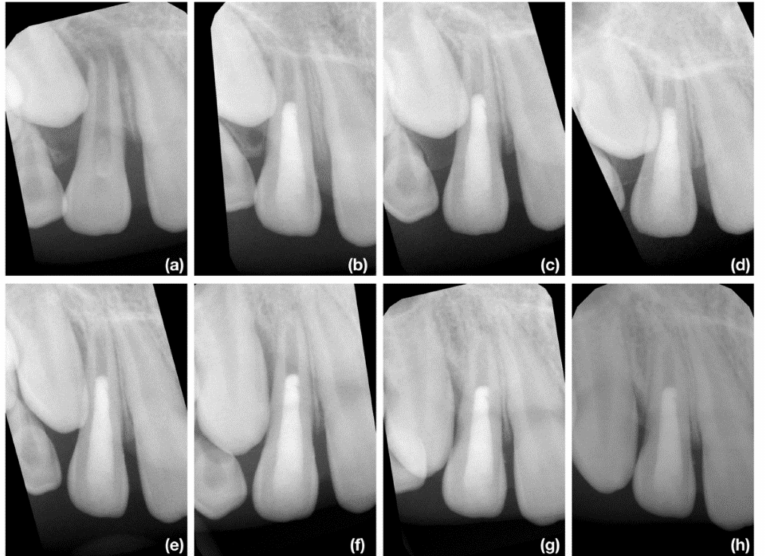
Figure 8. The illustrative case of the least successful course after REP. The 8-year-boy girl was referred for endodontic treatment approximately 12 months after eruption of tooth 12. ( a ) The diagnostic X-ray of tooth 12. The radiopaque invagination is evident in cervical part of tooth; ( b ) The X-ray taken immediately after finishing REP; ( c ) The control X-ray at 3-months follow up. The periapical lesion of tooth 21 was reduced in size. No visible signs of apposition of mineralized tissue; ( d ) The control X-ray at 6-months follow up. There are no signs of apposition of newly produced mineralized tissue; ( e ) The control X-ray at 9-months follow up. In the most apical part of the root mineralized tissue is evident, which fills apical 2 mm of root; ( f ) The control X-ray at 12-months follow up. The amount of produced tissue is similar to 9-months follow-up; ( g ) The control X-ray at 18-months follow up. The newly produced mineralized tissue is thickening with slight apposition on root canal wall in apical third. The mineralization of detached apical papilla is evident; ( h ) The control X-ray at 24-months follow up. Despite some apposition in apical 2–3 mm the radiological appearance is very similar to postoperative